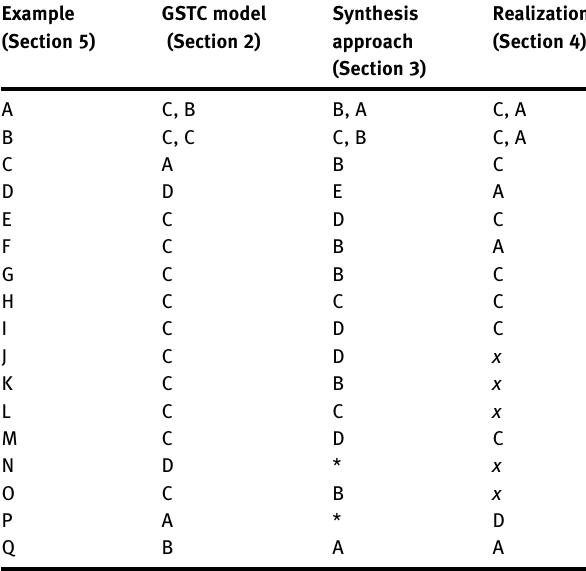
Table  : Summaryofboundaryconditions,synthesisapproach,and realization